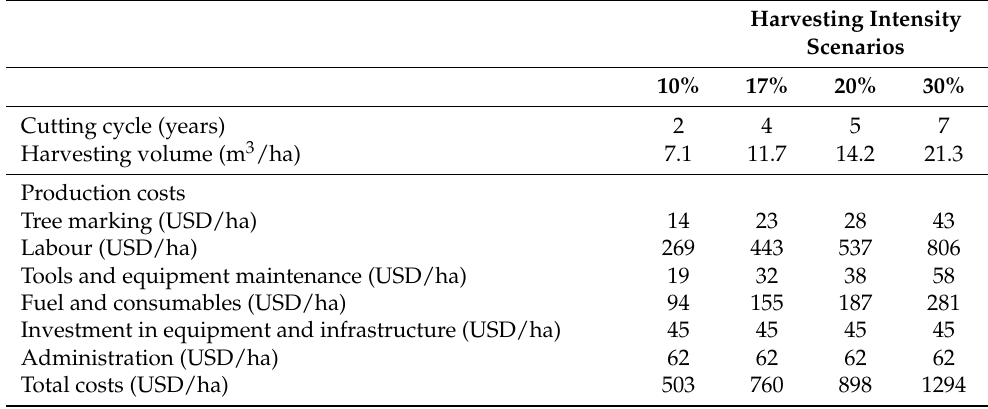
Table 4. Financial indicators from variation in harvesting volume based in Las Cañadas. NPV = Net Present Value, IRR = Internal Rate of Return. Amounts in USD are rounded up. The cost of tree marking used is for the volume